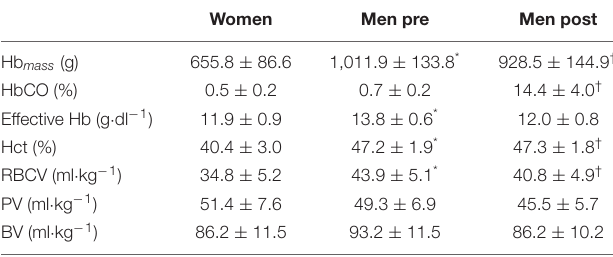
TABLE 2 | Hematological variables in women and men prior to and after blood normalization.